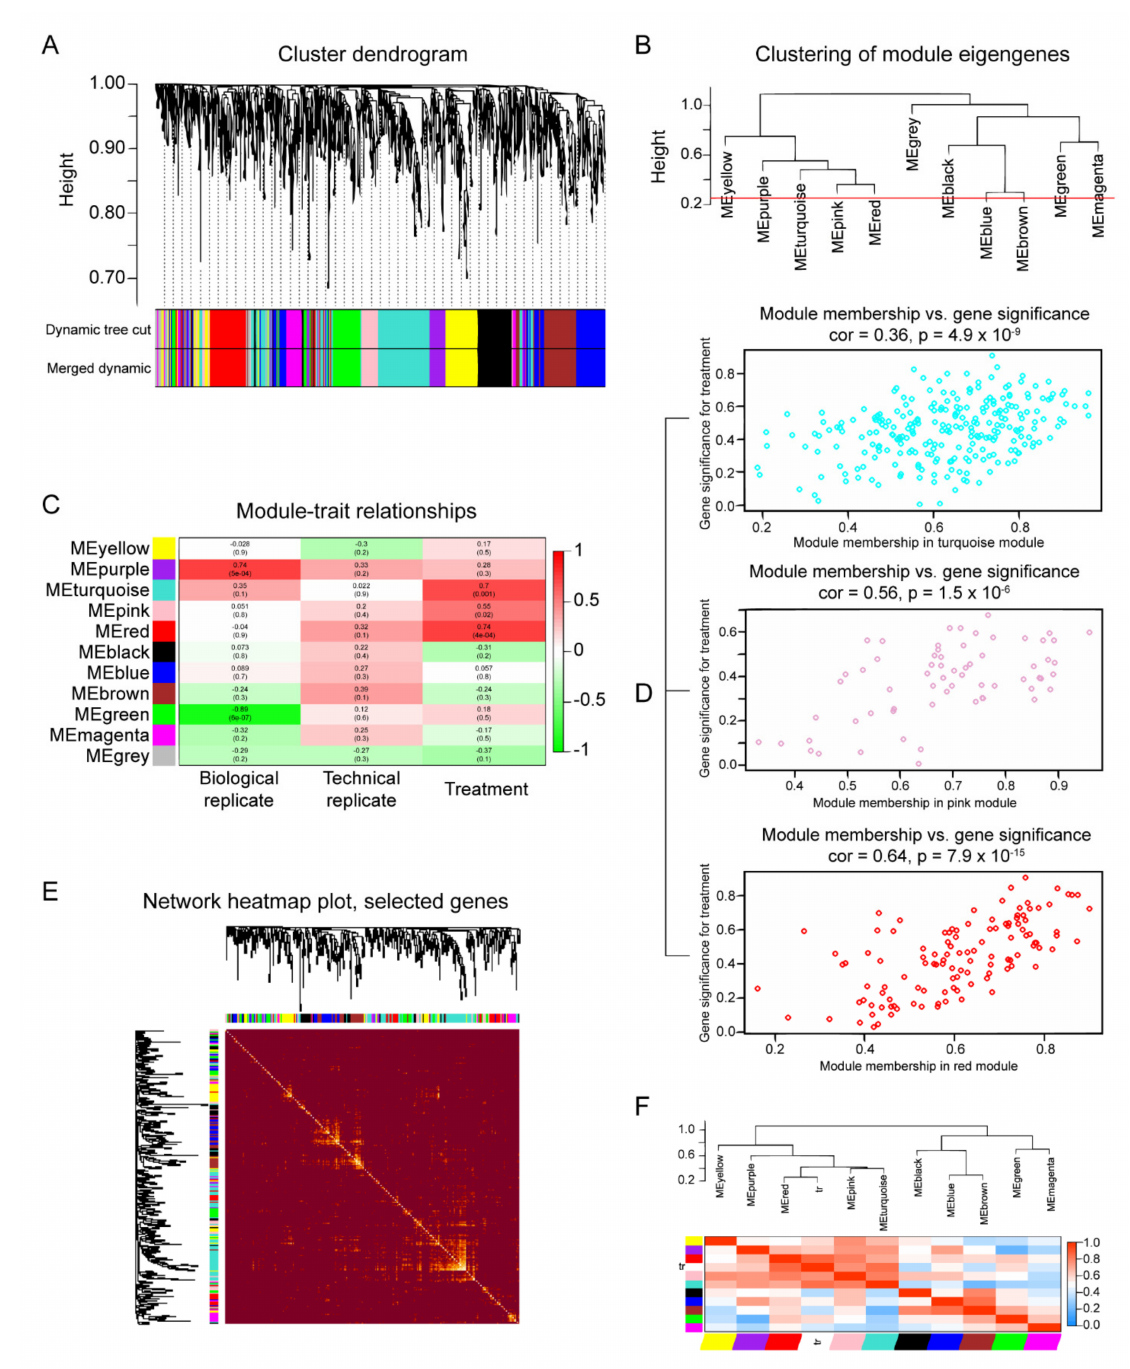
Figure 6. WGCNA analysis. ( A ) Average linkage hierarchical clustering gene dendrogram showing modules identified by Dynamic Tree Cut and merged dynamic at the lower side. ( B ) Dendrogram of module eigengenes (ME) identified by their colors, displaying the modules found in the clustering analysis, the red line represents the cutting-edge for merging modules. ( C ) Heatmap plot displaying the correlation of the adjacencies in the eigengene modules (rows) along treatment and biological and technical replicates. ( D ) Scatterplots of gene significance (GS) versus module membership (MM) for the modules “red”, “pink”, and “turquoise”. ( E ) Topological overlap in the gene network, brighter squares show modules of expression displaying high topological overlap, darker areas represent low topological overlap between proteins in the network (rows and columns). ( F ) Heatmap of the correlation between different modules and the weight trait